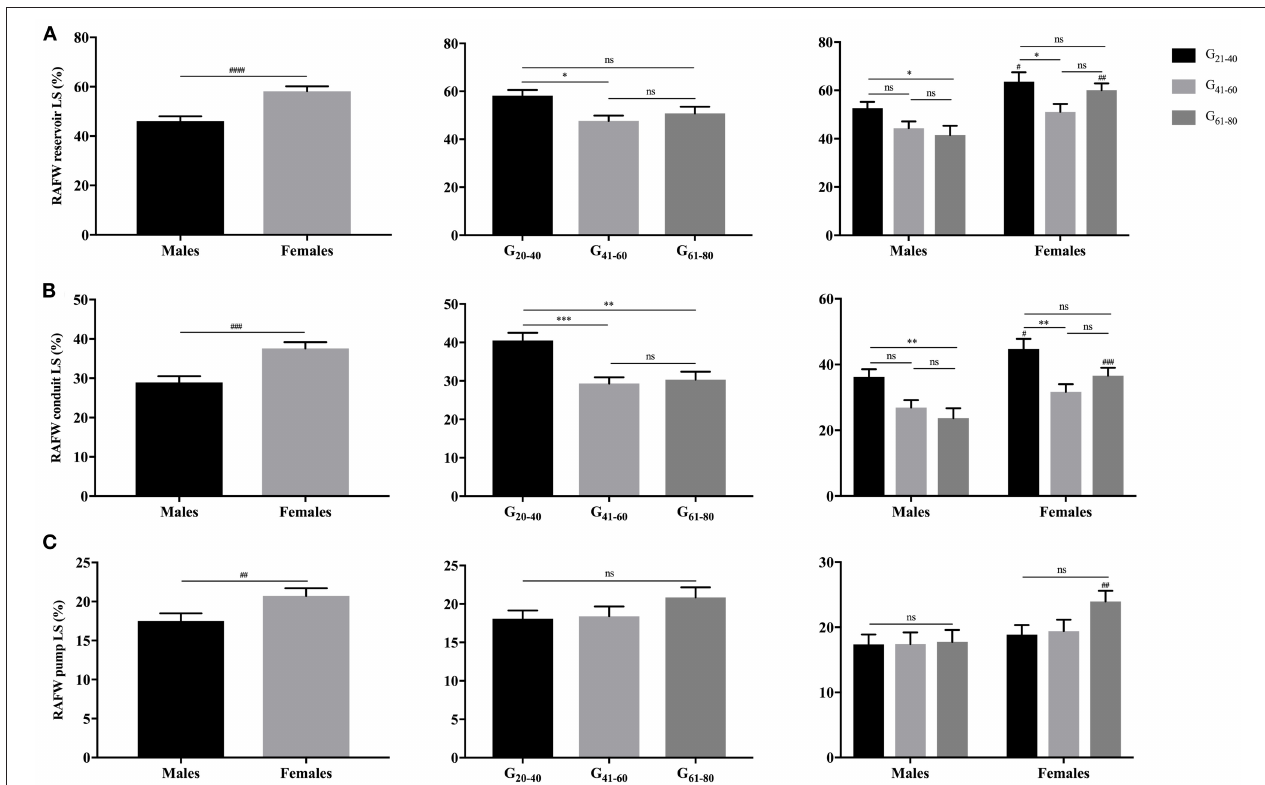
FIGURE 6 | Gender- and age-related differences of RAFW reservoir LS (A) , conduit LS (B) , and pump LS (C) . ## P < 0.01, ### P < 0.001, #### P < 0.0001: gender-related difference; * P < 0.05, ** P < 0.01, *** P < 0.001; ns, not significant.